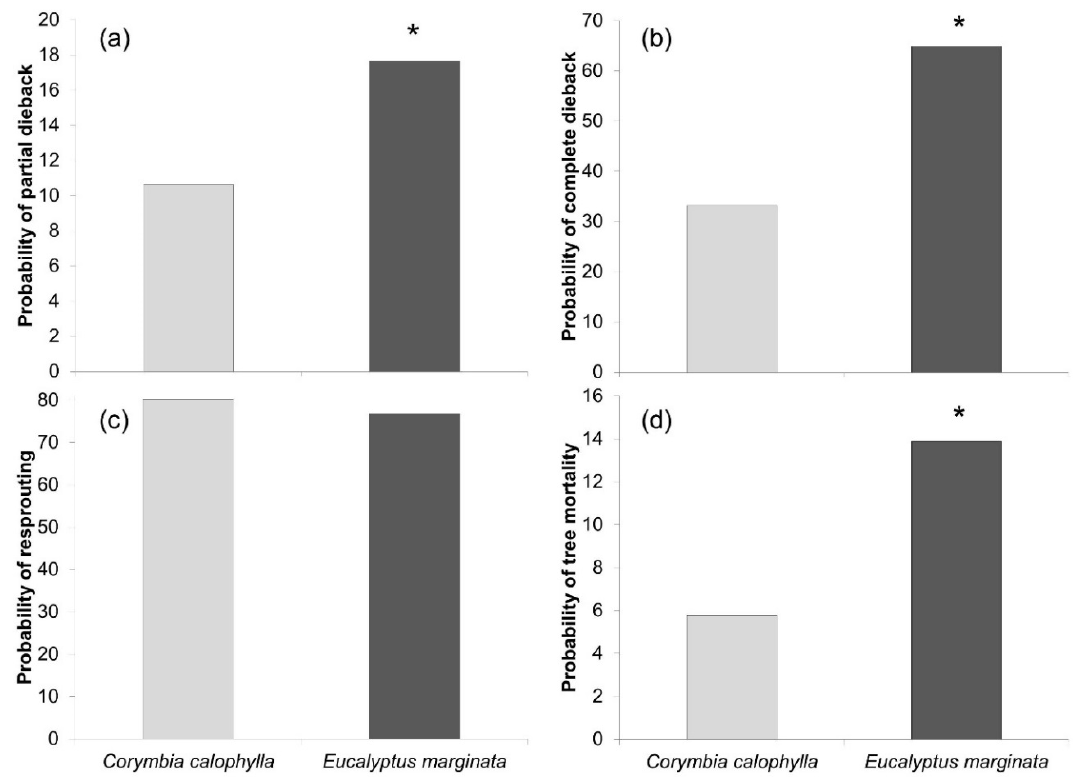
Figure 3. The probability of Corymbia calophylla and Eucalyptus marginata trees experiencing: ( a ) partial crown dieback; ( b ) complete crown dieback; ( c ) resprouting (of trees that experienced dieback); and ( d ) overall tree mortality, following drought in the Northern Jarrah Forest, Western Australia. An asterisks indicates significantly higher probabilities from generalized mixed models at alpha =